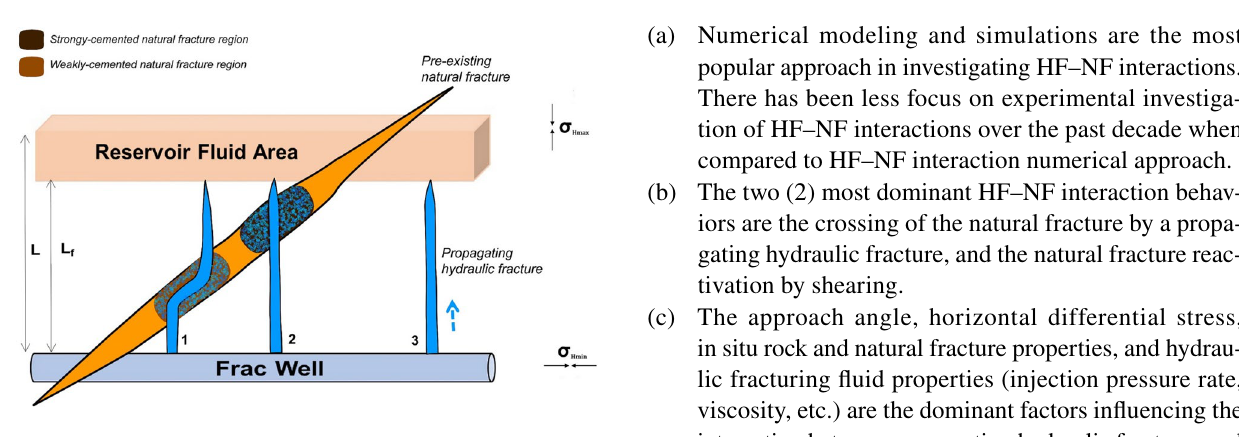
Fig. 6 3D Schematic description of interactions between propagating hydraulic fracture and pre-existing natural fracture during pre-frac L L test. : fracture half-length; NF: pre-existing f : Fluid lag length; natural fracture; HF: propagating hydraulic fracture; 𝜎 H max : maximum horizontal stress; 𝜎 H min : minimum horizontal stress. Modified after Advani et al.